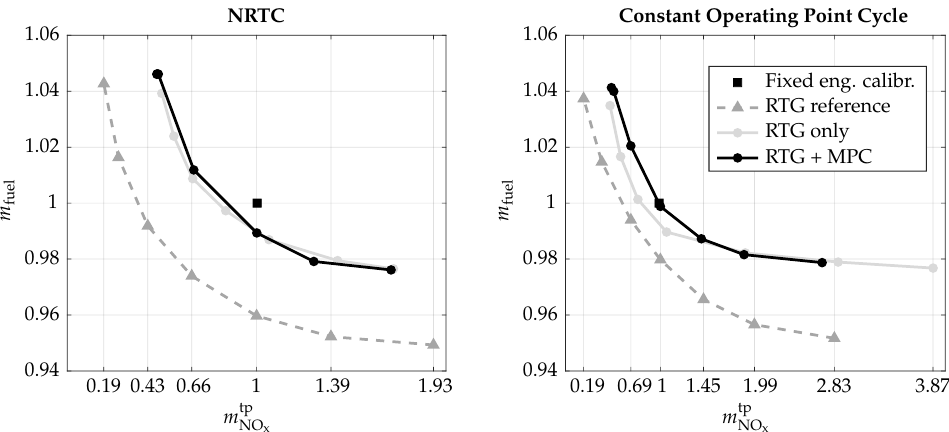
Figure 8. Pareto fronts obtained by setting different limits on the emitted tailpipe NO x mass. The black square marker shows the operation with the fixed engine calibration. The gray triangular markers show the results from the RTG optimization for different NO x limits. The gray circular markers show the corresponding measured operation with the RTG result used in a purely feedforward fashion, i.e., without feedback from the MPC. The black circular markers show the corresponding measured operation with the full predictive supervisory controller, i.e., with feedback from the MPC. The plot on the left shows the results for the NRTC, while the plot on the right shows the results for a mission consisting of a constant speed of 1900rpm and a constant torque of 200Nm for the duration of 1800s. All values were normalized.